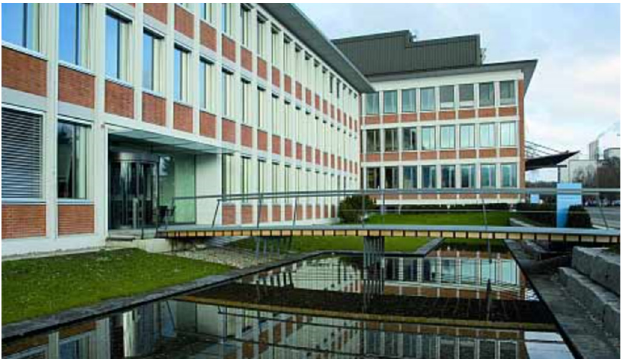
Figure 1. Empa bowstring arch footbridge [14]. Reprinted with permission from ref. [14]. Copyright 2009 Empa.